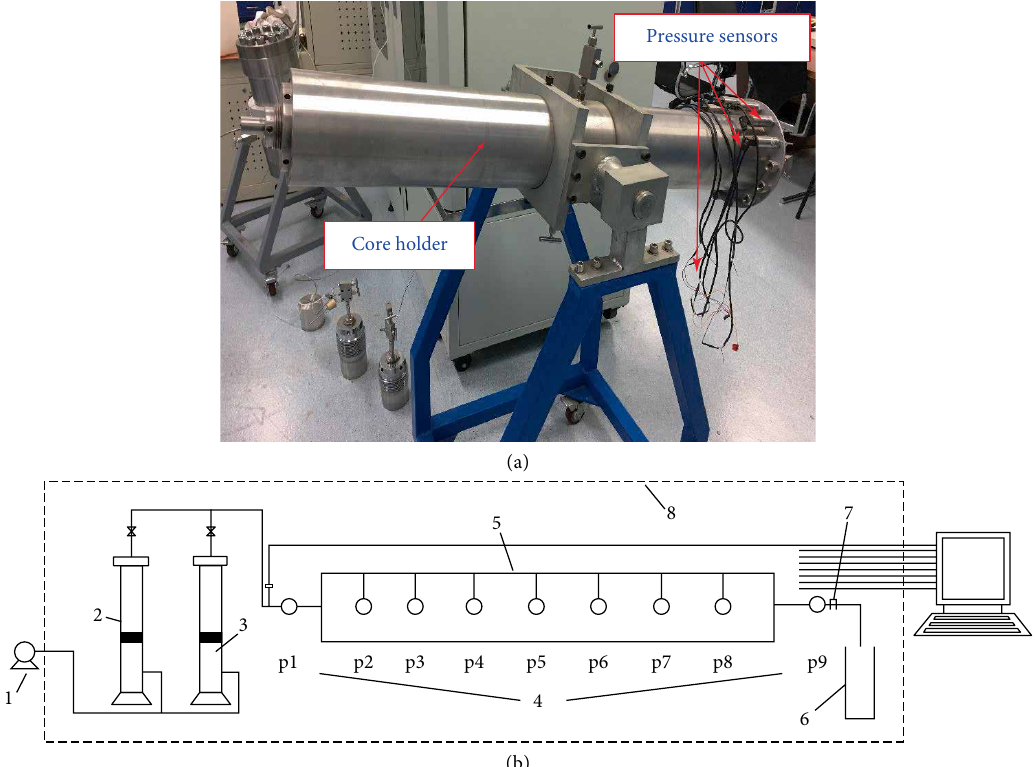
Figure 7: Schematic illustration of long core flooding apparatus. 1: ISCO pump; 2: brine/injected gas; 3: simulated crude oil; 4: pressure transducers; 5: core holder; 6: measuring bottle; 7: back-pressure valves; 8: